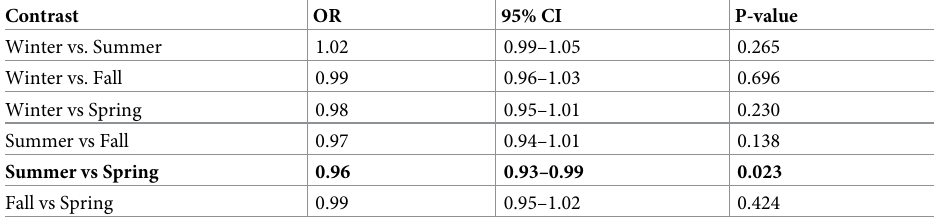
� Contrasts based on model presented in Table